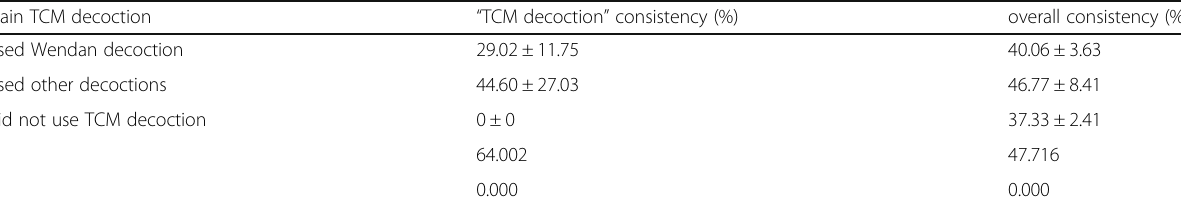
Table 9 Relation between application of Wendan decoction and index “ TCM decoction ” consistency, overall consistency